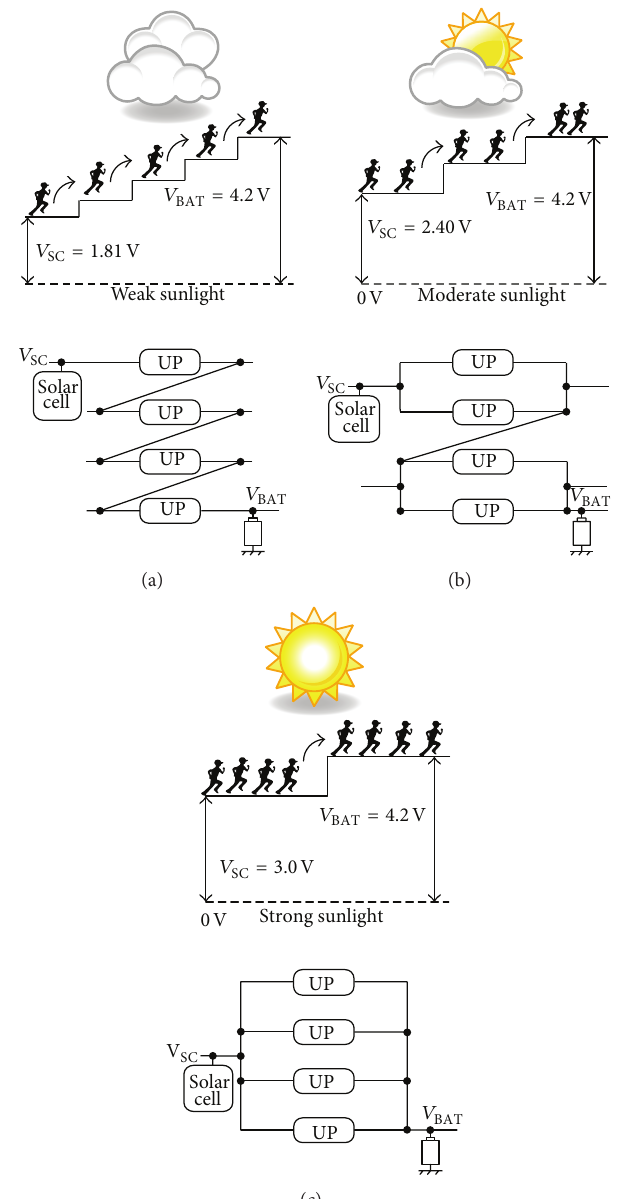
Figure 2: (a) Conceptual diagram of operation of RCP circuit and the serial architecture in weak sunlight condition, (b) conceptual diagram of operation of RCP circuit and the parallel-serial architecture in moderate sunlight condition, and (c) conceptual diagram of operation of RCP circuit and the parallel architecture in strong sunlight